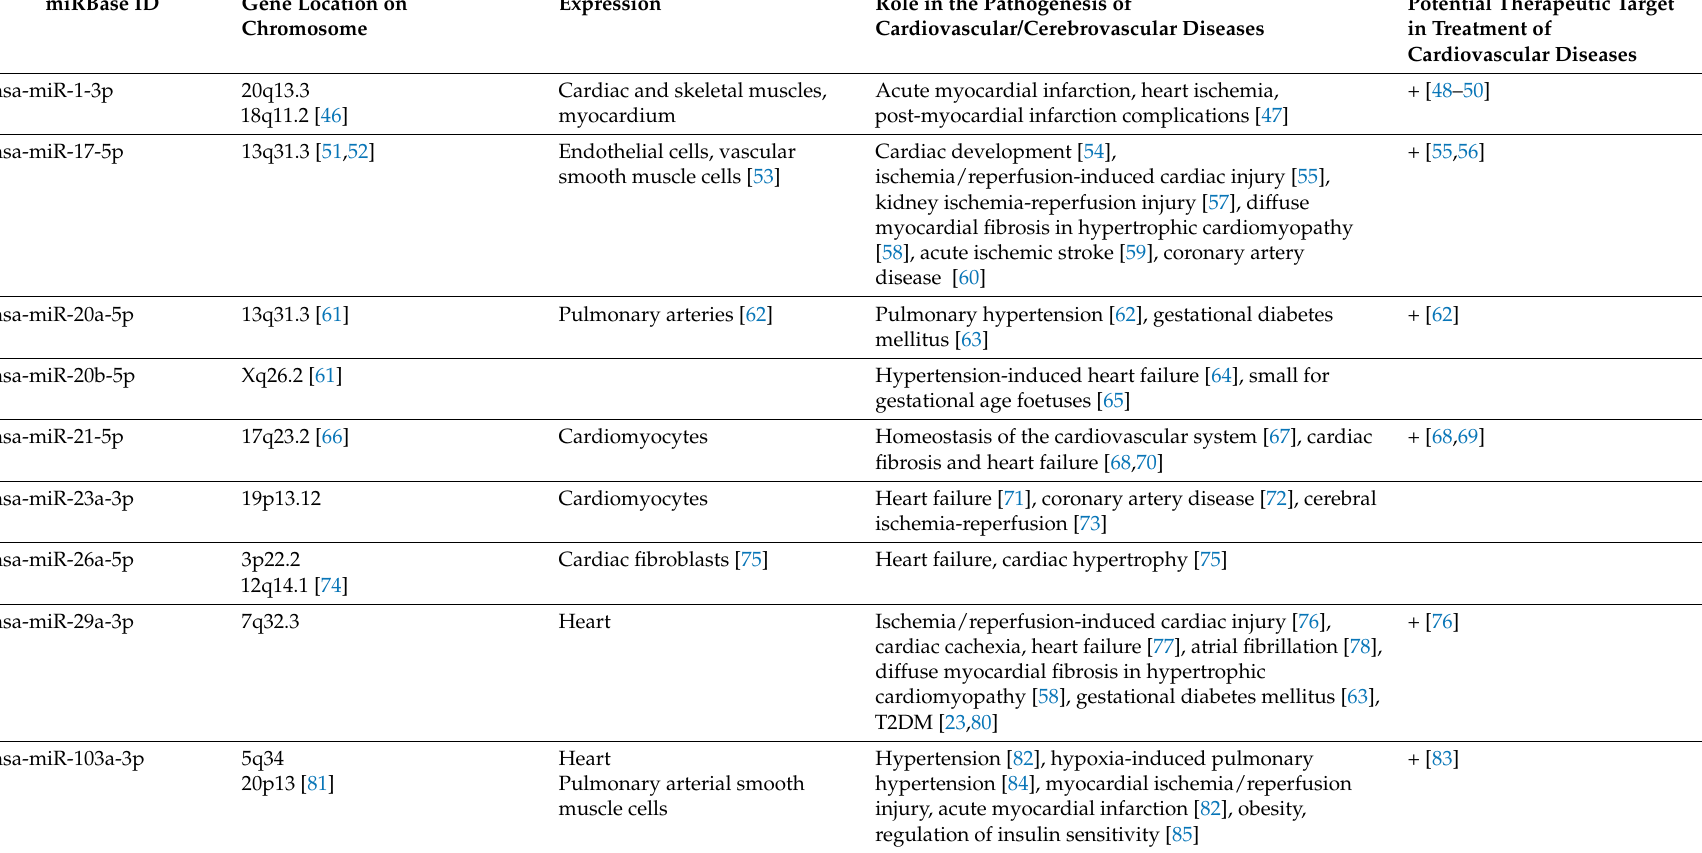
Table 2. The role of differentially expressed microRNAs in children descending from gestational hypertension, preeclampsia and/or fetal growth restriction complicated pregnancies in the pathogenesis of cardiovascular/cerebrovascular